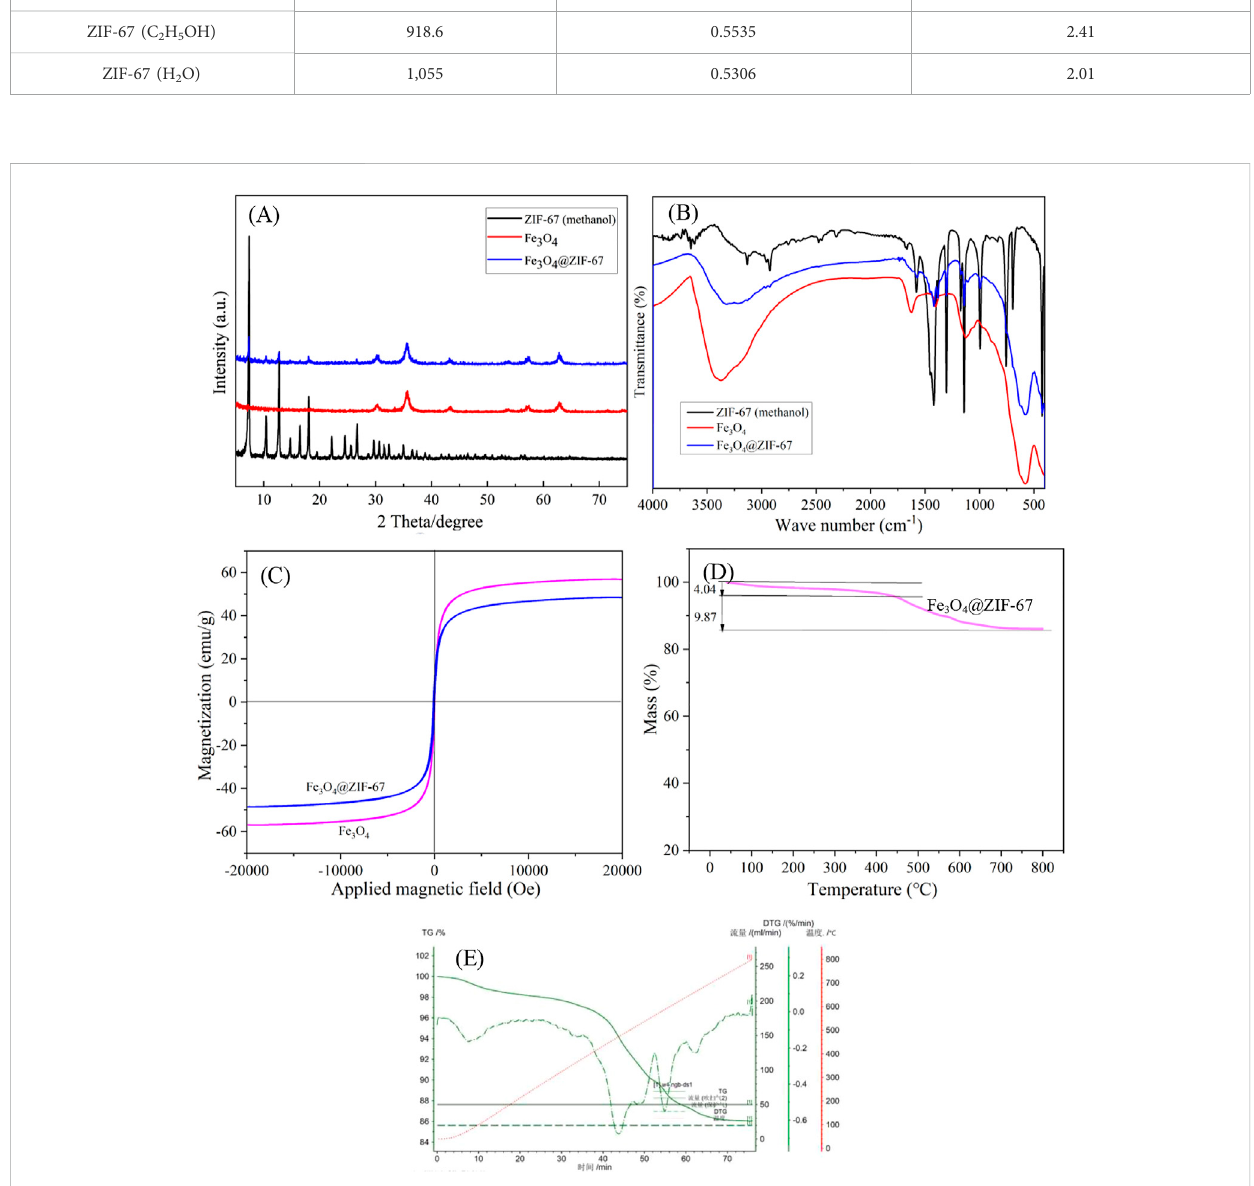
FIGURE 3 The XRD (A) , FT-IR (B) , VSM (C) , and TGA (D, E) of Fe 3 O 4